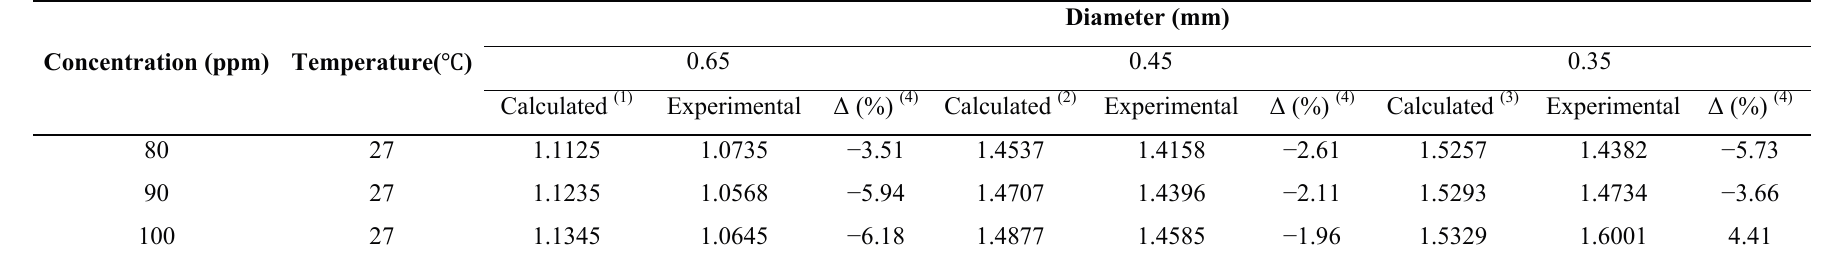
Table 1. Model validation of the developed